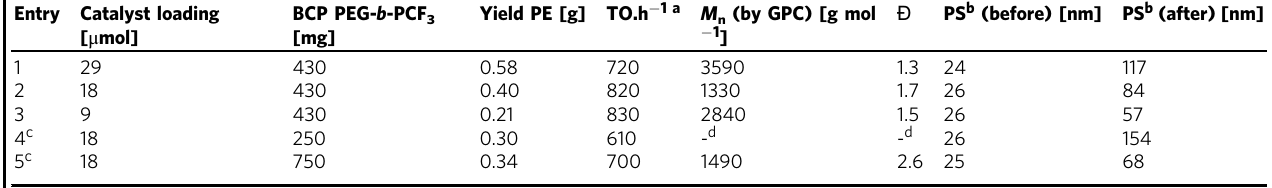
Molecular weight below detection limit of GPC